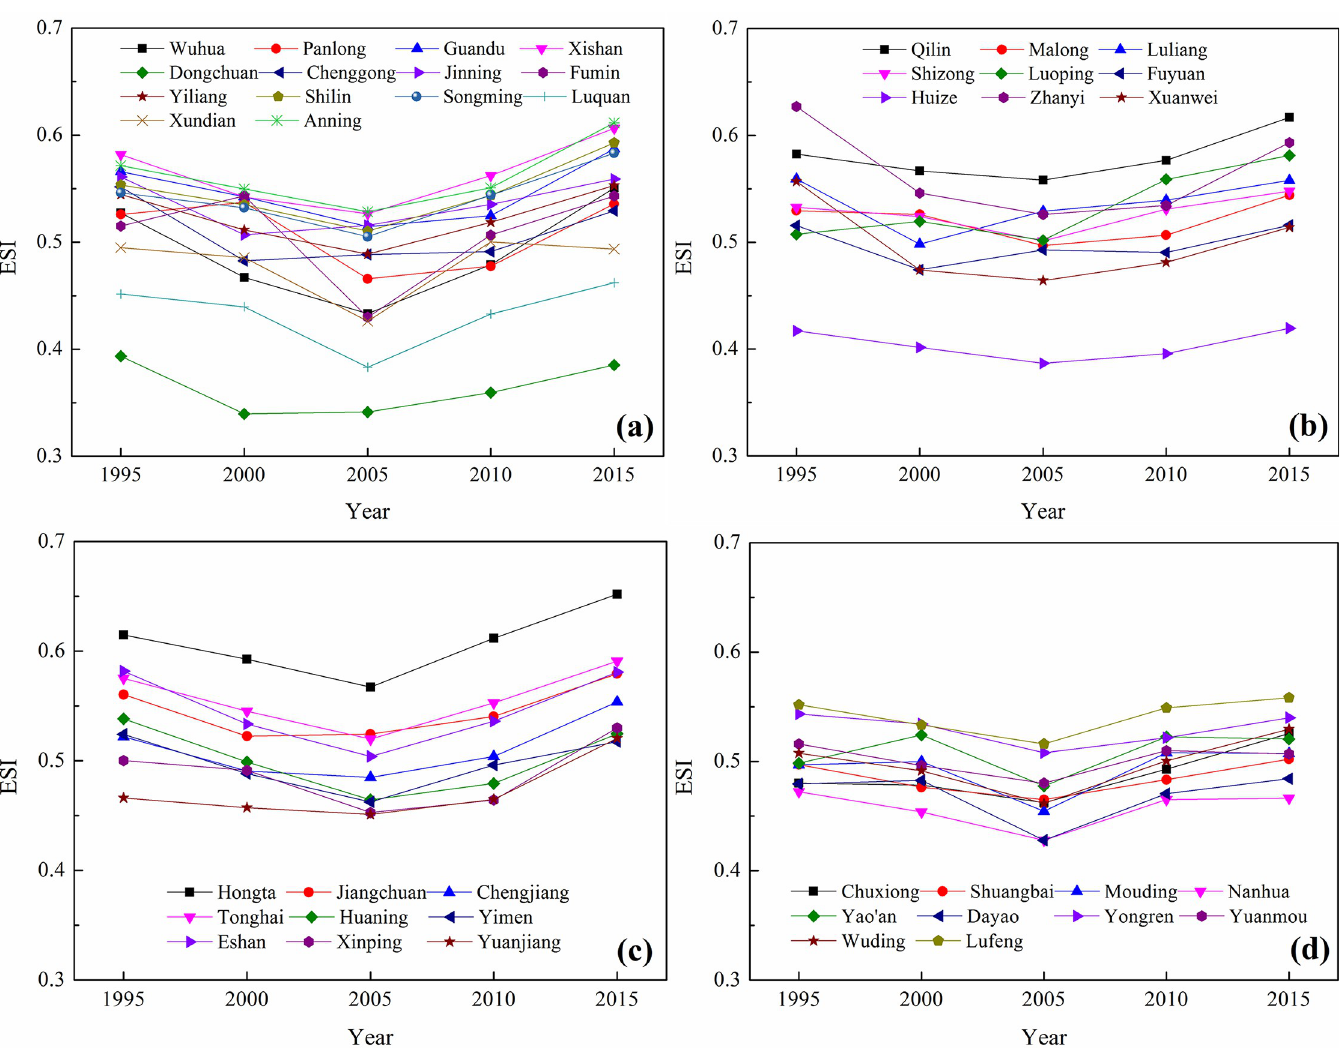
Fig 4. ESI values and change trends in CYP at the county level. (a) Kunming Prefecture, (b) Qujing Prefecture, (c) Yuxi Prefecture, and (d) Chuxiong